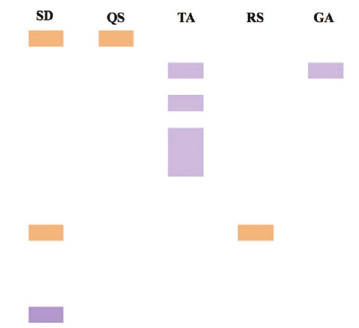
Figure 1 - Thin layer chromatography of Spondias dulcis Forst F bark ethanolic extract. SD, S. dulcis extract; QS, Quercetin standard; TA, Tan- nic acid standard; RS, Rutin standard; GA, Gallic acid